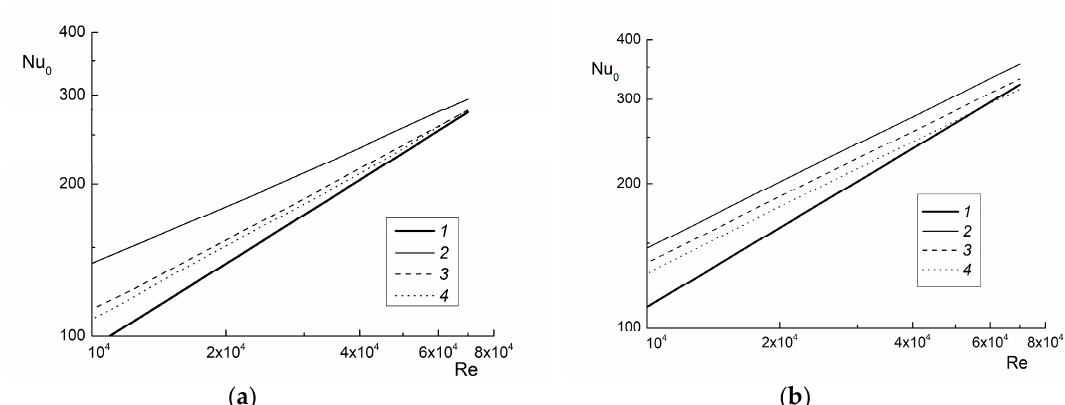
Figure 8. The effect of jet Reynolds number on heat transfer at the stagnation point at H / D = 2 ( a ) and 6 ( b ). DC = 0.5, f = 150 Hz, St = 0.17. 1 —steady-state impinging jet ( f = 0 Hz), 2 —rectangular, 3 —sinusoidal, 4 —triangular.